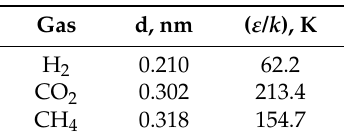
Table 1. Effective diameter, d , and the depth of the Lennard-Jones potential, ( ε /k ), for the gases under study [42].